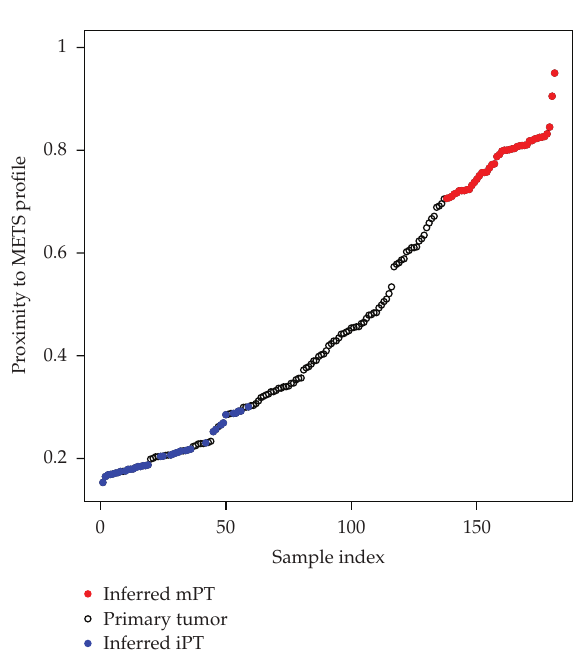
Figure 6: Plot of ranked proximity score for MSK signature 2. Proximity represents the number of times a particular sample clustered with the MSK metastasis profile 2. The samples with higher scores (cid:2) red points (cid:3) are classified as inferred mPTs and the samples with lower scores (cid:2) blue points (cid:3) are classified as inferred iPTs. Primary tumors (cid:2) hollow points (cid:3) interspersed with the blue iPT tumors were excluded as iPTs for MSK signature 2 because they did not consistently classify as iPTs in the proximity analysis using MSK signature